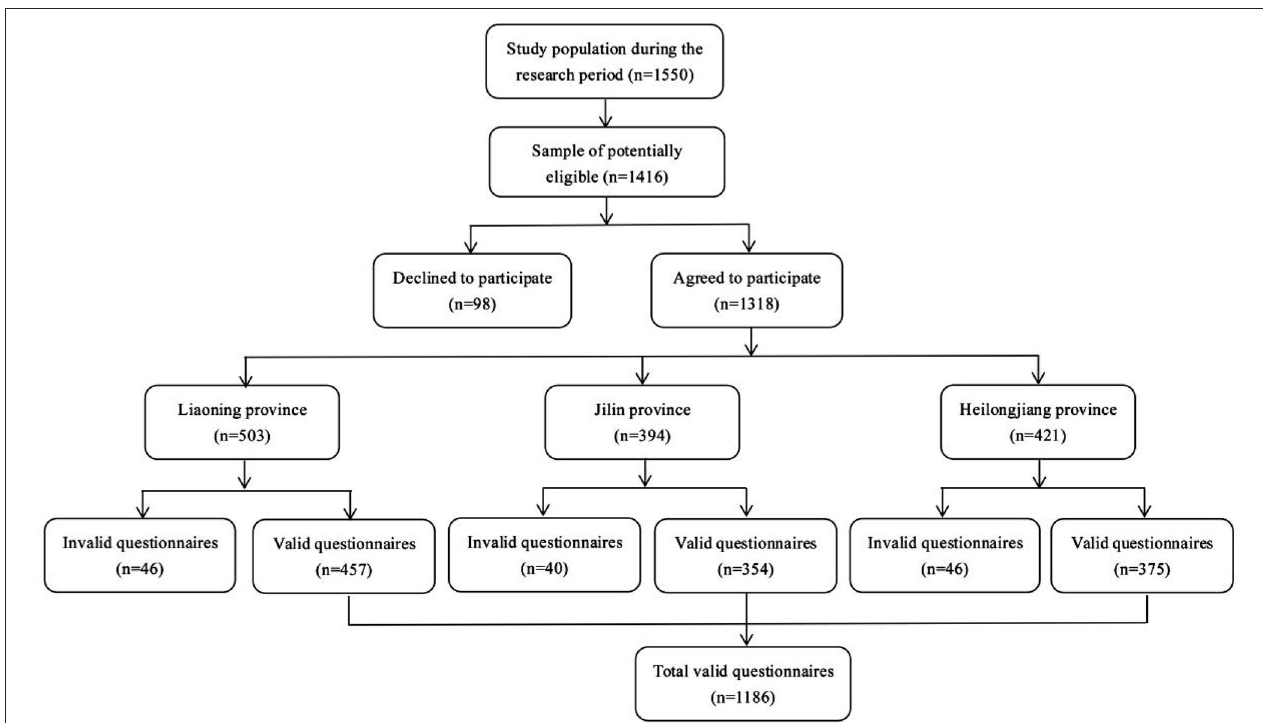
FIGURE 1 | Flowchart of